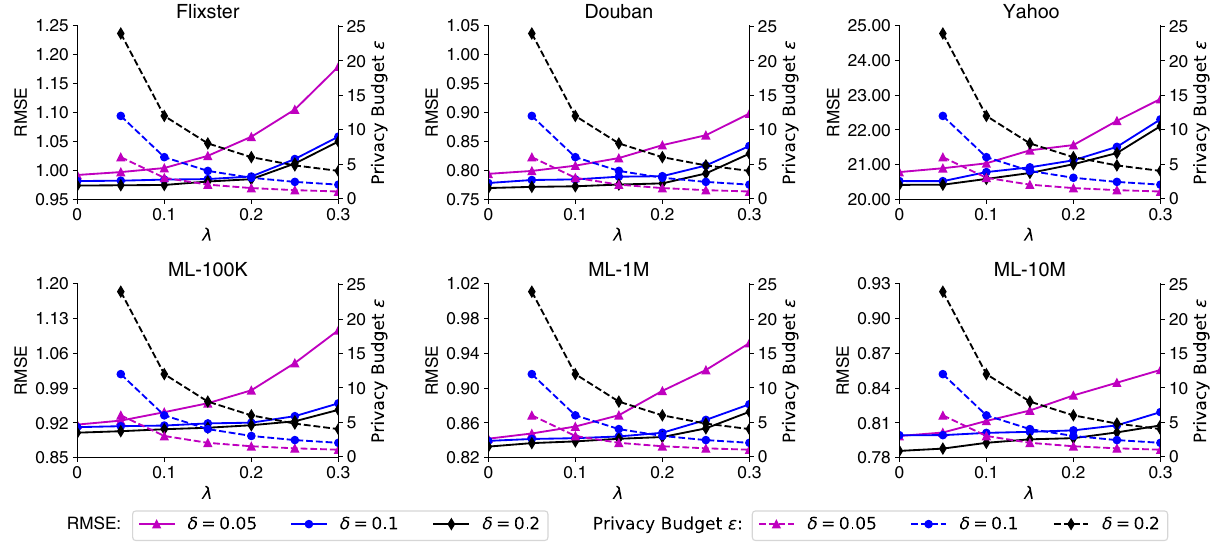
Fig. 4 The personalization RMSE (left y -axis) and privacy budget ϵ (right y -axis) w.r.t. different clipping threshold δ and noise strength λ . Lower RMSE means better performance and lower privacy budget means better privacy protection. The privacy budget under λ = 0 is in fi nite. The performance sacri fi ce is similar when the clipping threshold δ is 0.1 or 0.2, while it becomes much heavier when δ is 0.05. The performance loss is also larger when a stronger noise strength is used. FedPerGNN achieves 3-differential privacy under δ = 0.1 and λ = 0.2 (the number of epochs is 3). NATURE COMMUNICATIONS| (2022) 13:3091